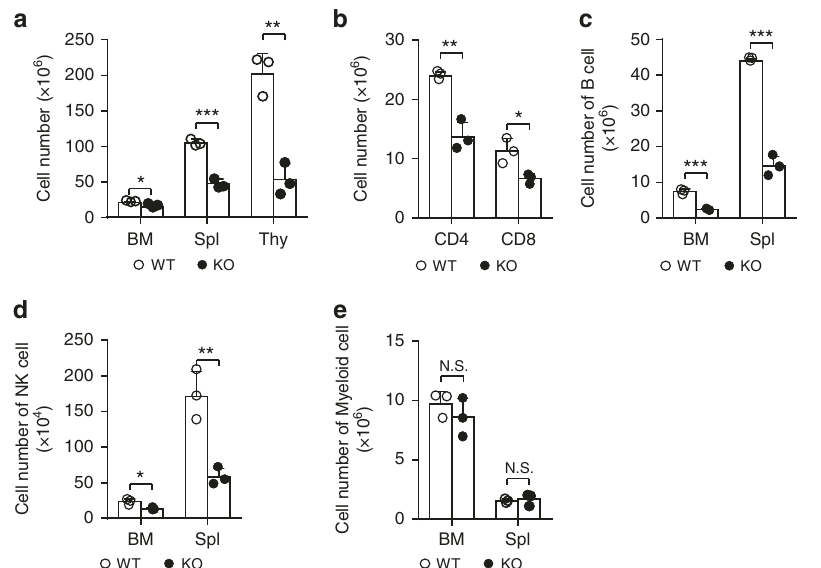
Fig. 1 Lymphocytopenia in med23-de fi cient mice. a Absolute cell numbers of bone marrow (BM), spleen (Spl), and thymus (Thy) from WT and KO mice ( n = 3). b Absolute cell numbers of CD4 (CD4 + CD8 − ) and CD8 (CD4 − CD8 + ) T cells in spleens of WT and KO mice ( n = 3). c Absolute cell numbers of B cells (B220 + ) in bone marrows and spleens of WT and KO mice ( n = 3). d Absolute cell numbers of NK cells (NK1.1 + ) in bone marrows and spleens of WT and KO mice ( n = 3). e Absolute cell numbers of myeloid cells (Gr1 + /Mac1 + ) in bone marrows and spleens of WT and KO mice ( n = 3). The data are means± S.D., for all panels: * p < 0.05, ** p < 0.01, *** p < 0.001 by Student ’ s t -test, N.S. no signi fi cance